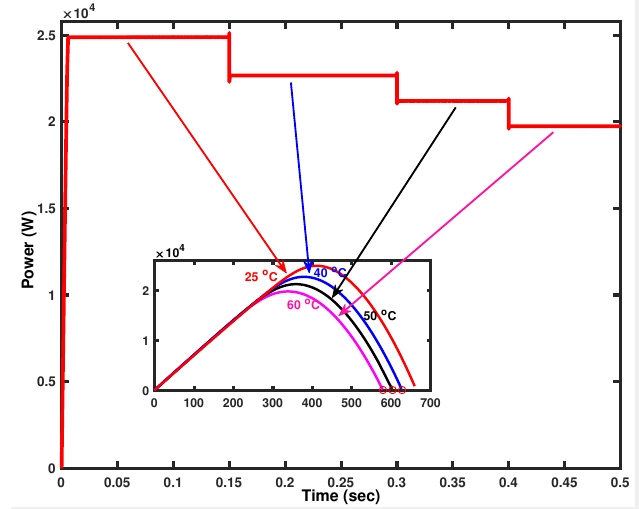
Figure 15. Voltage tracking in PV system under varying temperature conditions.